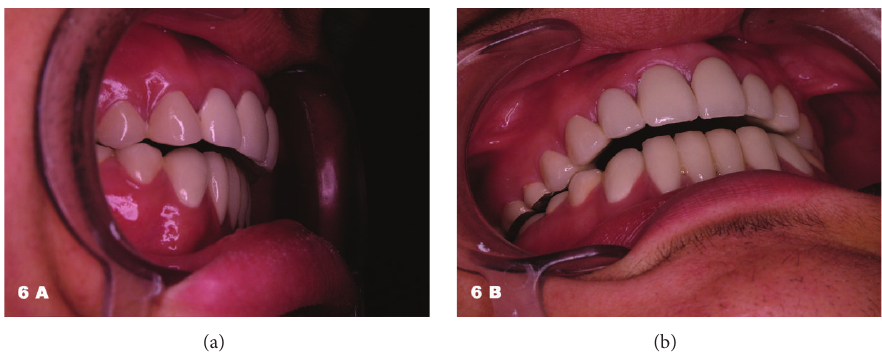
Figure 6: The anterior overbite was successfully restored. The outcome was highly esthetic.